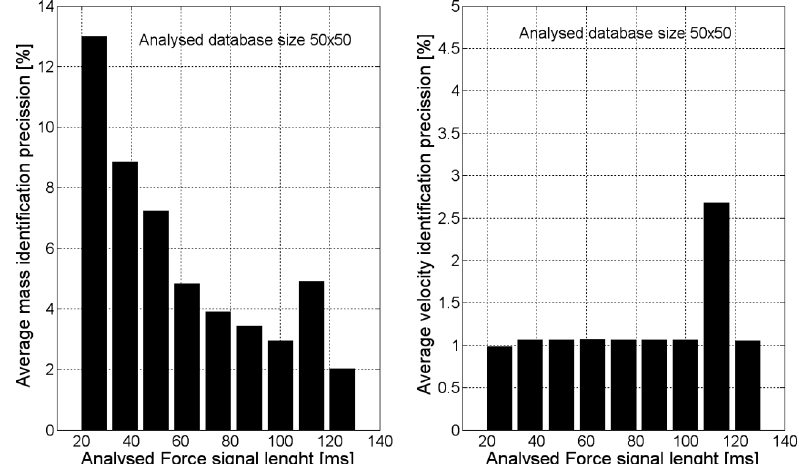
Fig. 16. Identi fi cation error as a function of analysed force signal length: mass identi fi cation (left), velocity identi fi cation (right).